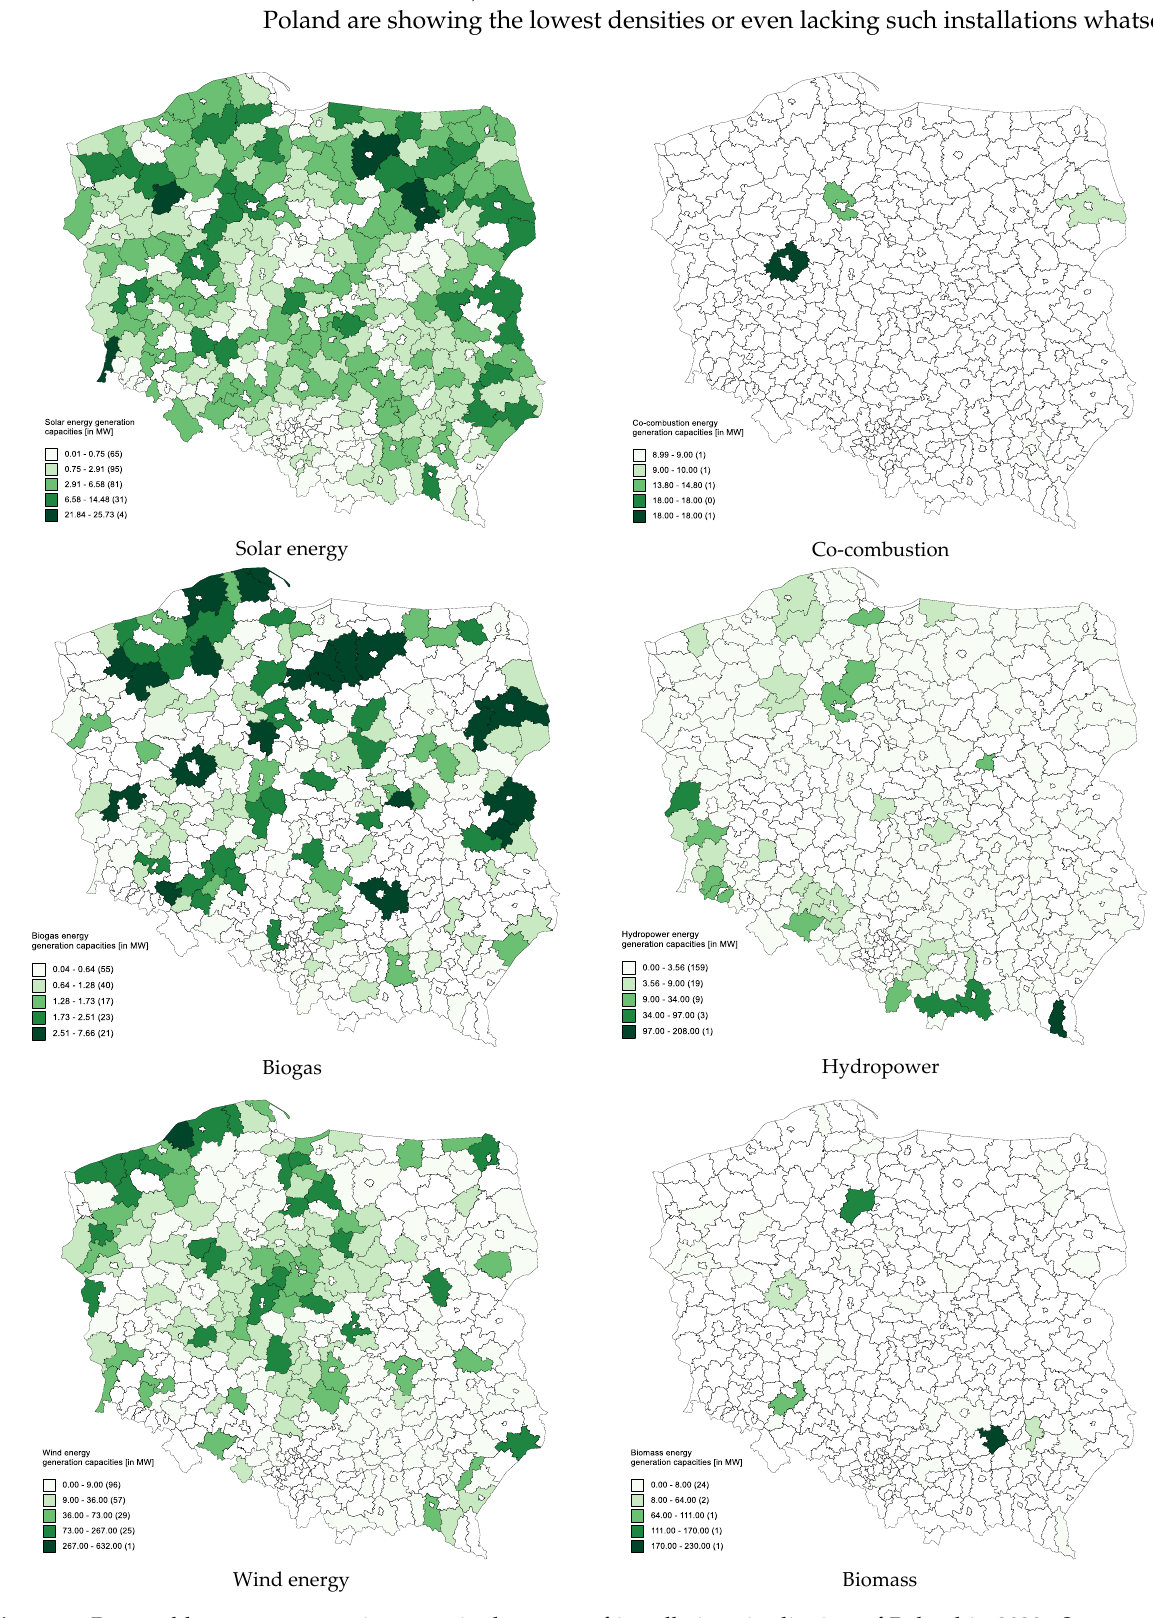
Figure 6. Renewable energy generation capacity by types of installations in districts of Poland in 2020. Source: own calculations and presentation.